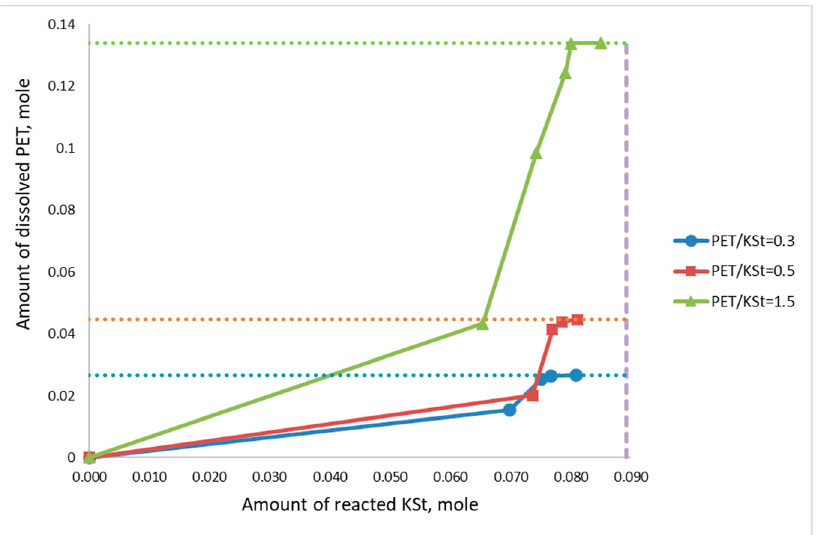
Figure 1. Waste PET dissolves in ethylene glycol for different initial molar ratios of PET/KSt at 190 °C. Horizontal lines are total amounts of PET; vertical lines are total amounts of KSt.